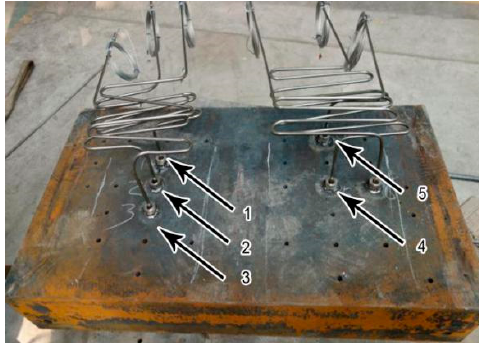
Figure 6. Sketch of the locations of thermocouples.